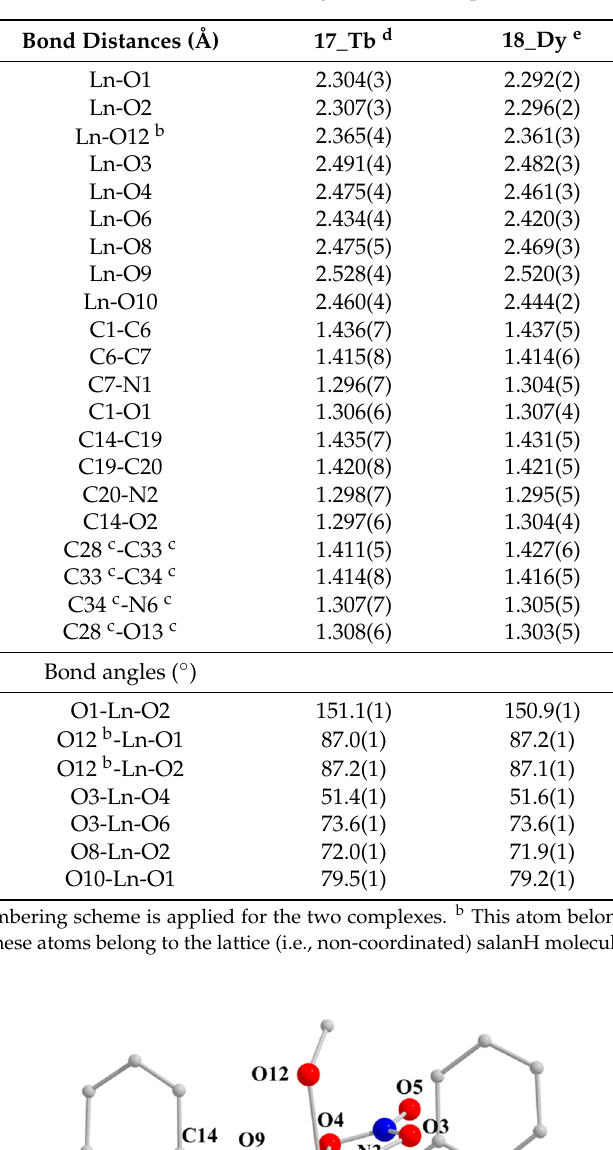
Table 3. Selected bond distances (Å) and angles (°) for complexes 17_Tb and 18_Dy a. Bond distances (Å)